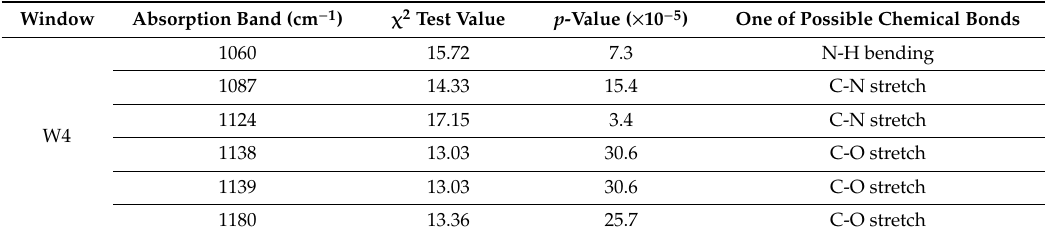
Table 2. Best predictors for H. pylori